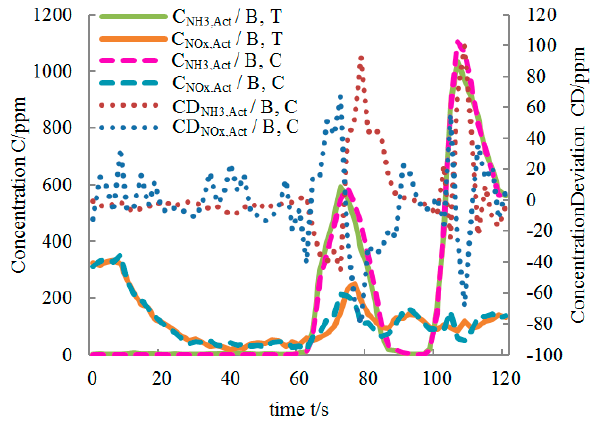
Figure 7. The values and deviations of the NO x and NH 3 before the correction.